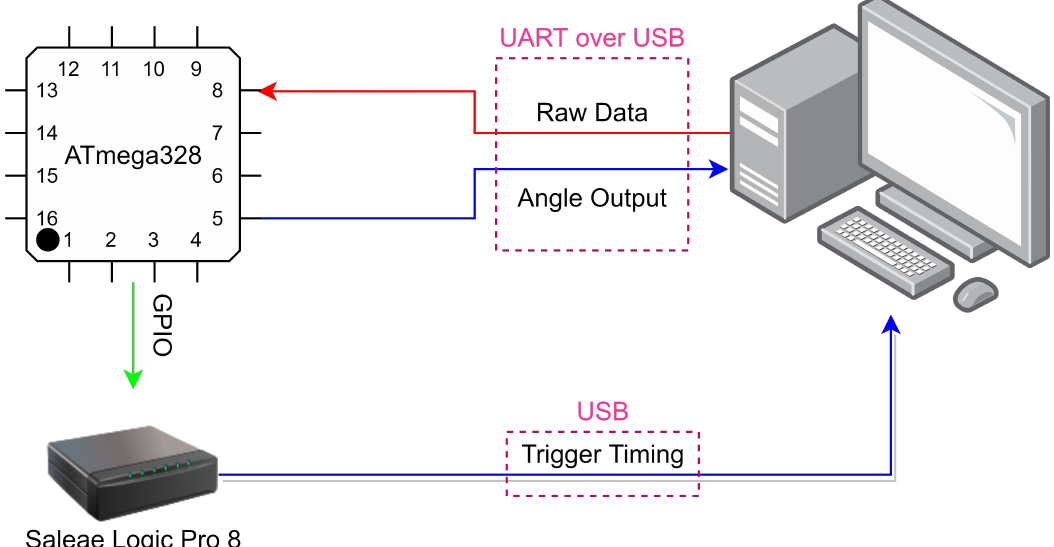
Figure 6. Test configuration 1 system architecture for hardware-in-the-loop simulation test.